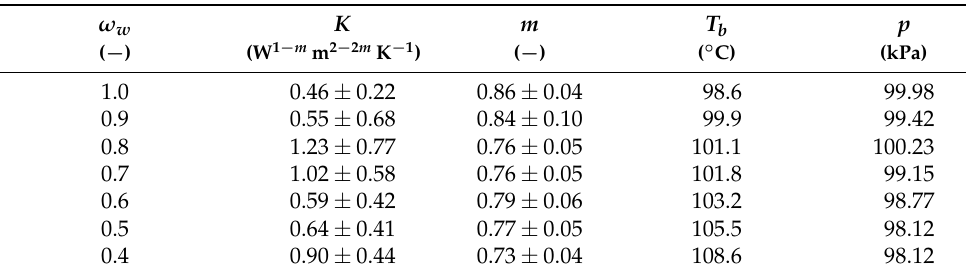
Table 7. Fitting parameters for Equation (6) with 95% confidence intervals, measured boiling temper- atures and pressures.